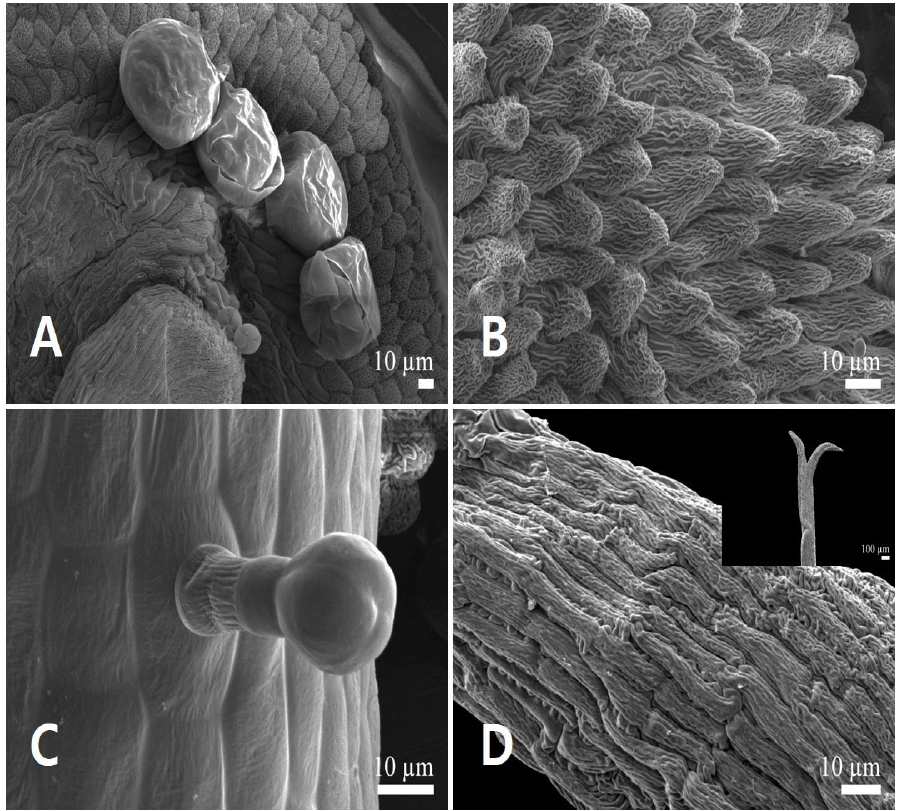
Figure 4. Scanning electron micrographs of the androecium and gynoecium in Leonurus japonicus . ( A , B ) Anther. ( A ) Anther glands. ( B ) Conical epidermal cells. ( C ) Capitate stalked glandular trichome on the filament. ( D ) Stigma surface (bilobate